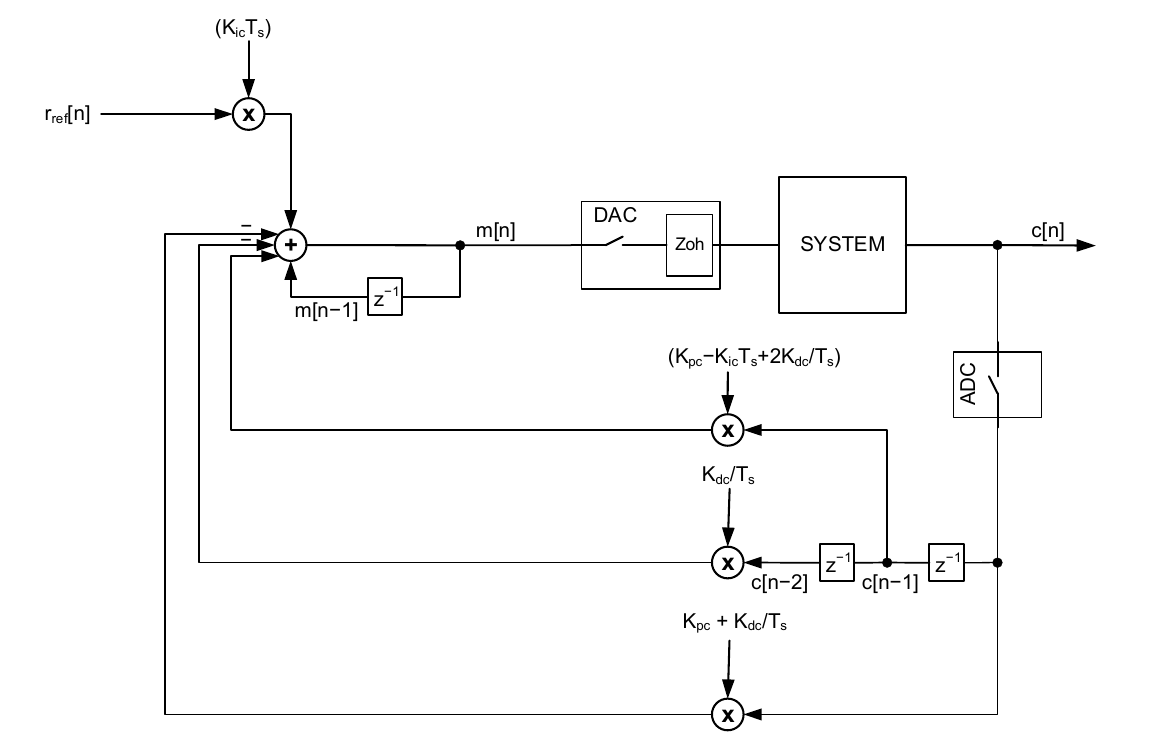
Figure 17. Using Velocity Form to Control the System. Converters are shown.